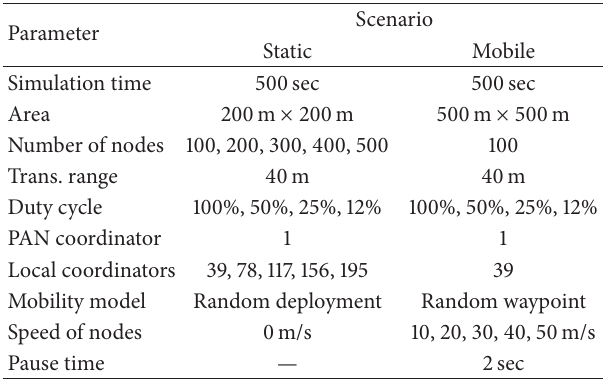
Table 2: Simulation